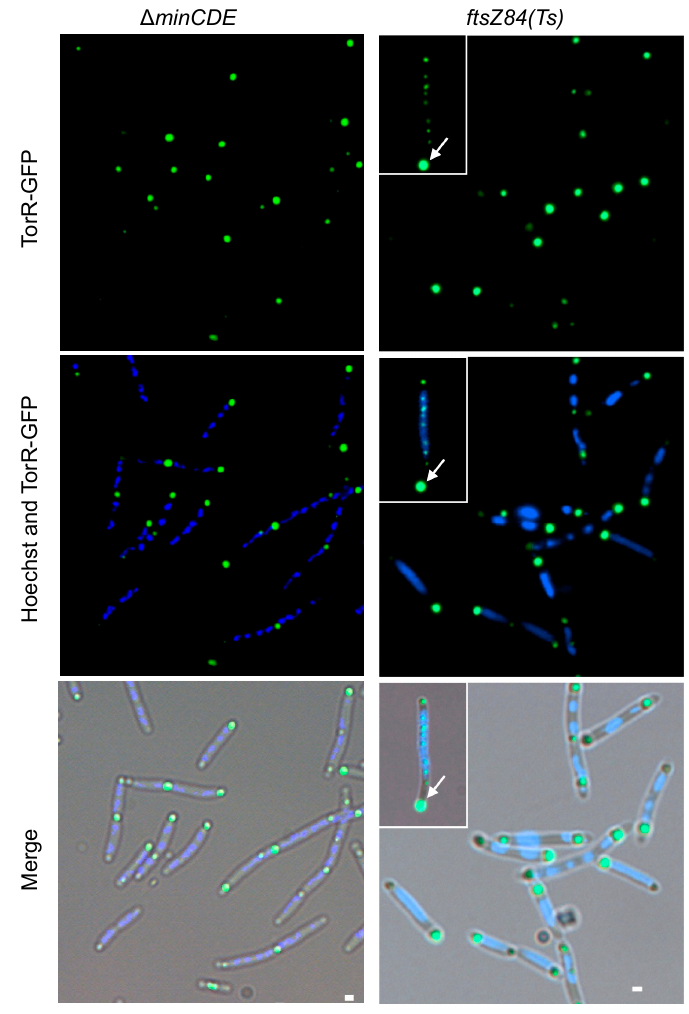
Figure 6. Formation of a ‘normal’ TorR ‐ GFP focus depends on FtsZ and the MinCDE proteins. Exponentially growing W3110 Δ torR Δ minCDE /pTorR ‐ GFP cells in ABTGcasa with IPTG at 37 °C were collected. Subcellular localization of TorR ‐ GFP and the nucleoids were visualized by fluorescence microscopy after 30 min staining in Hoechst33258 (the left panels). To inactivate the thermosensitive FtsZ84 protein, exponentially growing W3110 Δ torRftsZ84(Ts) /pTorR ‐ GFP cells in ABTGcasa at 30 °C were up ‐ shifted to the non ‐ permissive temperature (42 °C) for 2 h, subsequently TorR ‐ GFP and the nucleoids were visualized after staining with Hoechst33258. The arrow indicates the cell with an enlarged TorR ‐ GFP focus and several small TorR ‐ GFP foci during the time course at 42 °C. The scale bars represent 1 μ m.